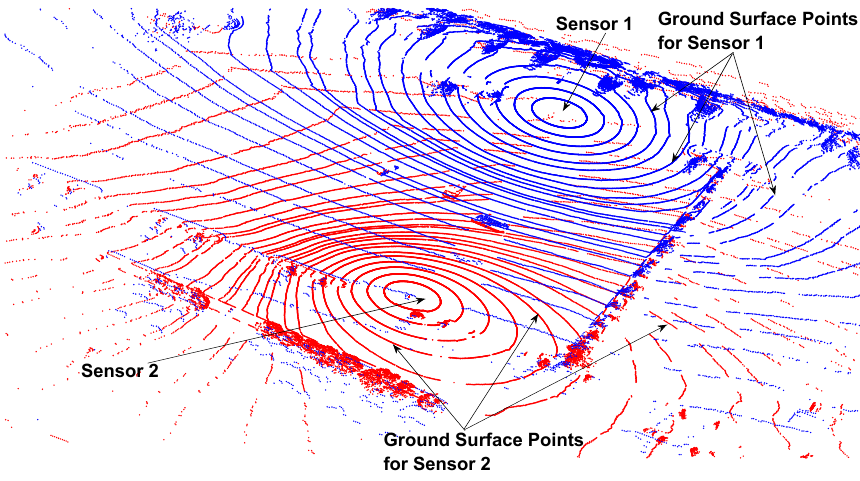
Figure 3. Example of ground points overlaps of two LiDAR datasets.